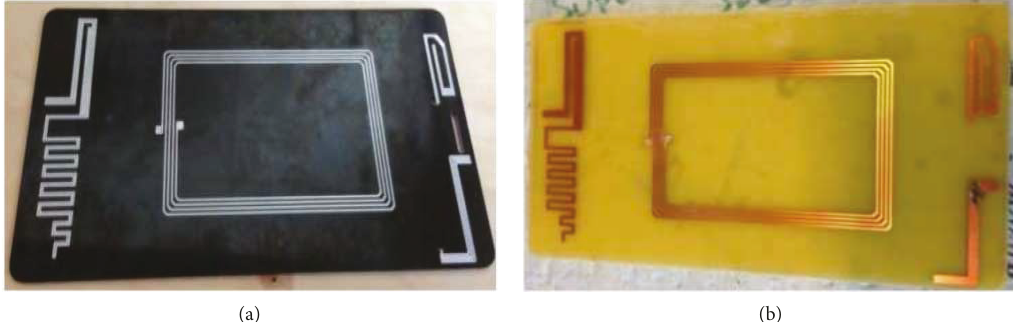
Figure 6: Aerosol jet-printed near- fi eld antenna by Optomec for near- fi eld communication. (a) Printed with silver nanoparticle ink. (b) Printed with Cu nanoparticle ink [43].